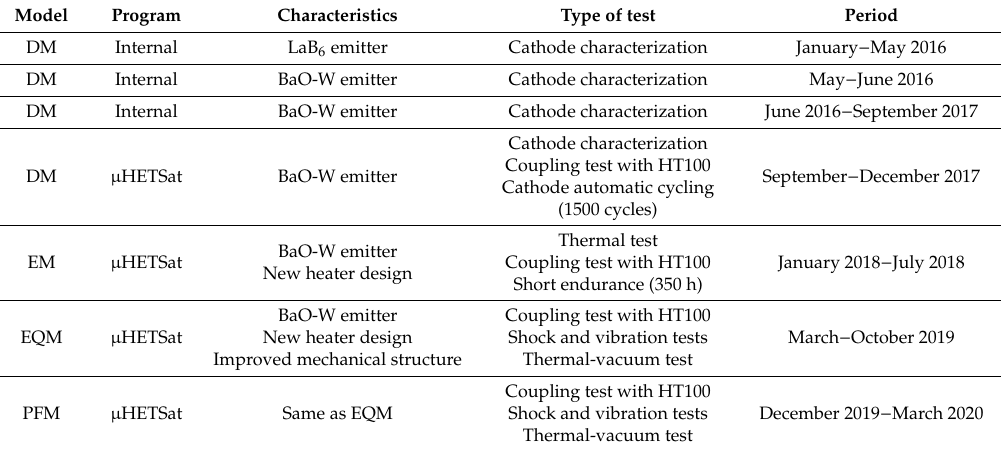
Table 2. History of HC1 cathode